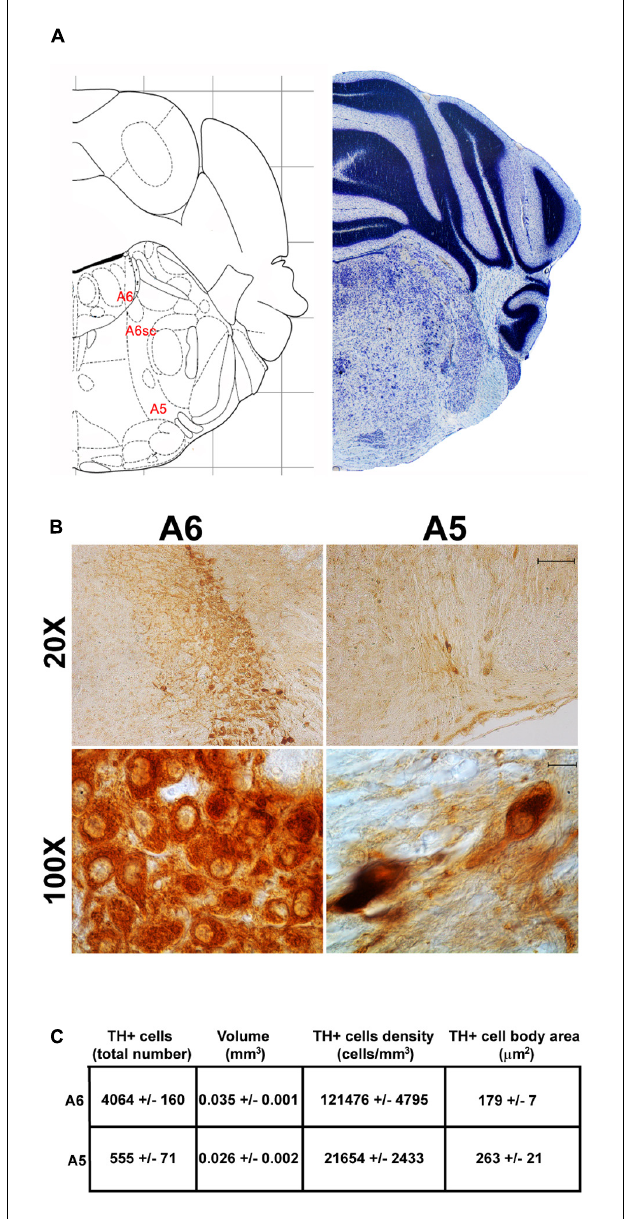
FIGURE 8 | Anatomical and morphometric analyses of TH-positive cell of the A6 and A5 catecholaminergic nuclei. (A) Nissl staining of the mouse brain at the Bregma level –5.34 (Paxinos and Franklin, 2001) showing the anathomical localization of A6, A6sc, and A5 noradrenergic group. (B) Representative images of TH immunoreactive cells of the A6 and A5. Images at higher magnification (100X) show the morphological features of these TH positive cells. Scale bar: 100 µ m for 20X and 10 µ m for 100X. The corresponding morphometric analyses are shown in (C) . Values are means ± SEM.